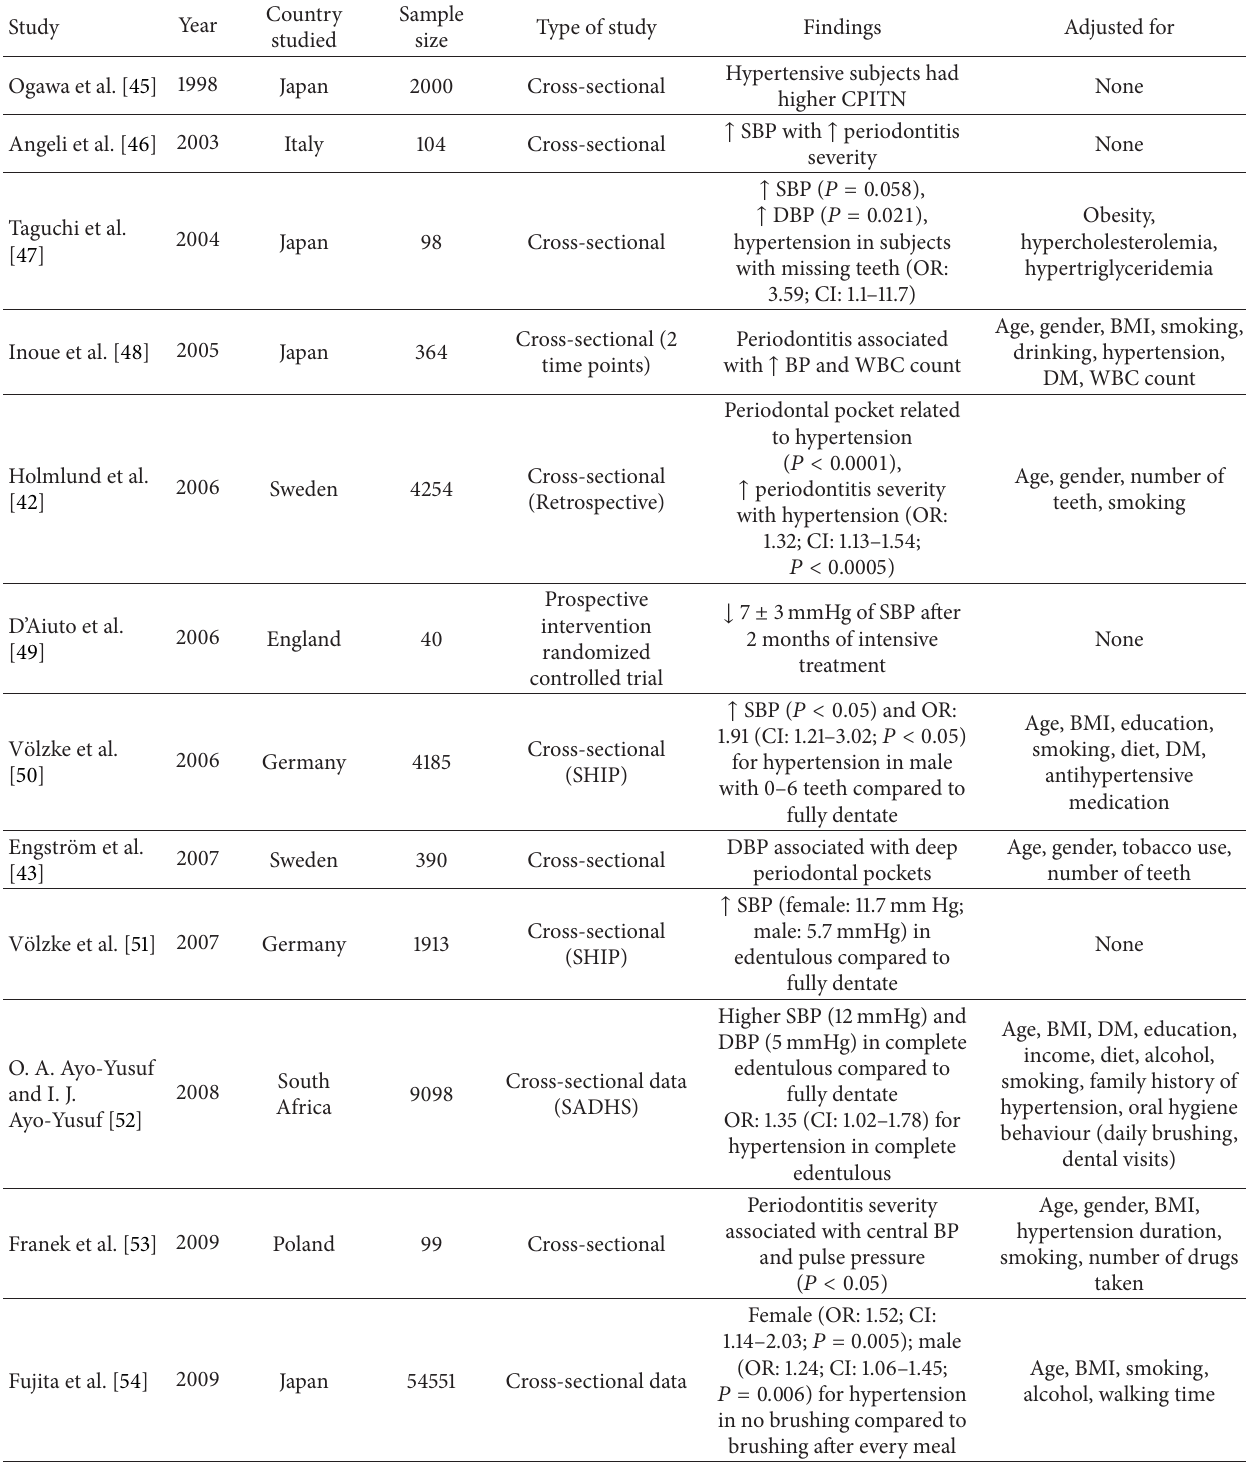
Table 1: Studies demonstrating significant association of hypertension and